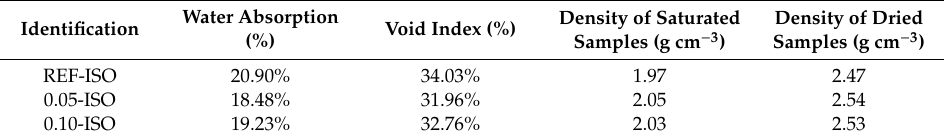
Table 4. Water absorption results.